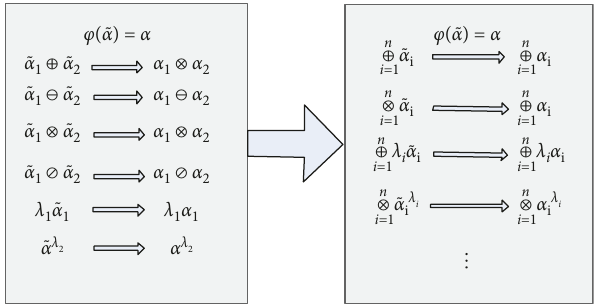
Figure 3: Interpretation of